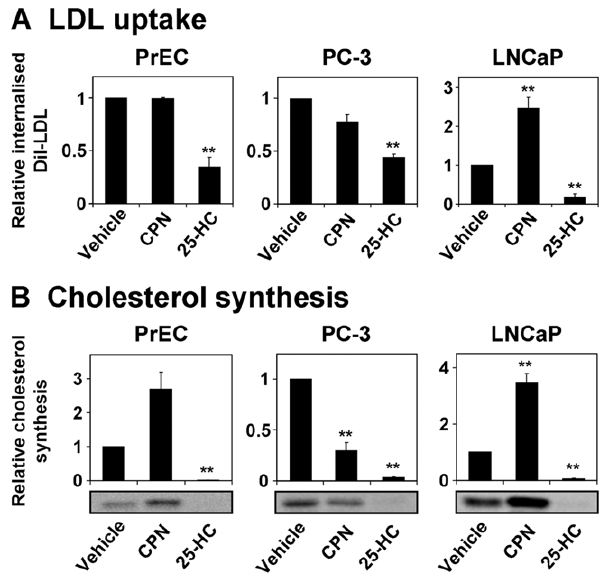
Figure 3. Sterol feedback regulation has functional effects in PCa cells. Cells were treated with the statin compactin (CPN, 5 m M) or the oxysterol 25-HC (1 m g/ml) for 24 h in Medium C. (A) Cells were prepared, treated, and assayed for DiI-LDL internalization as described in Materials and Methods. The amount of DiI-LDL internalized provides an indication of LDLR activity. Data are presented as mean + SEM, from